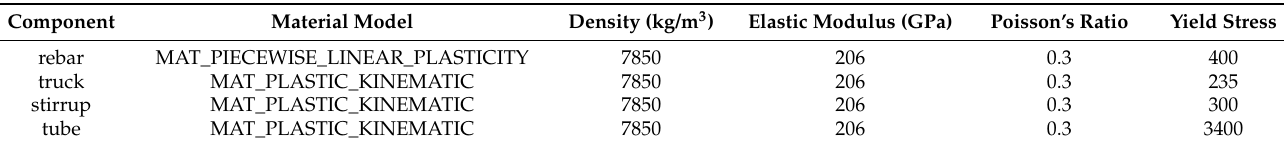
Table 2. Constitutive model and parameters of material.